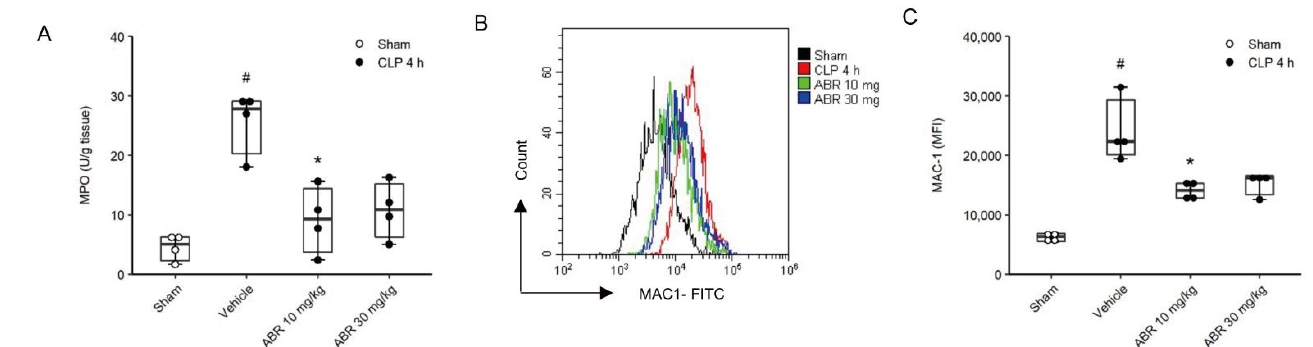
Figure 2. S100A9 regulates neutrophil recruitment. Mice were pre-treated with intraperitoneal injections of vehicle or